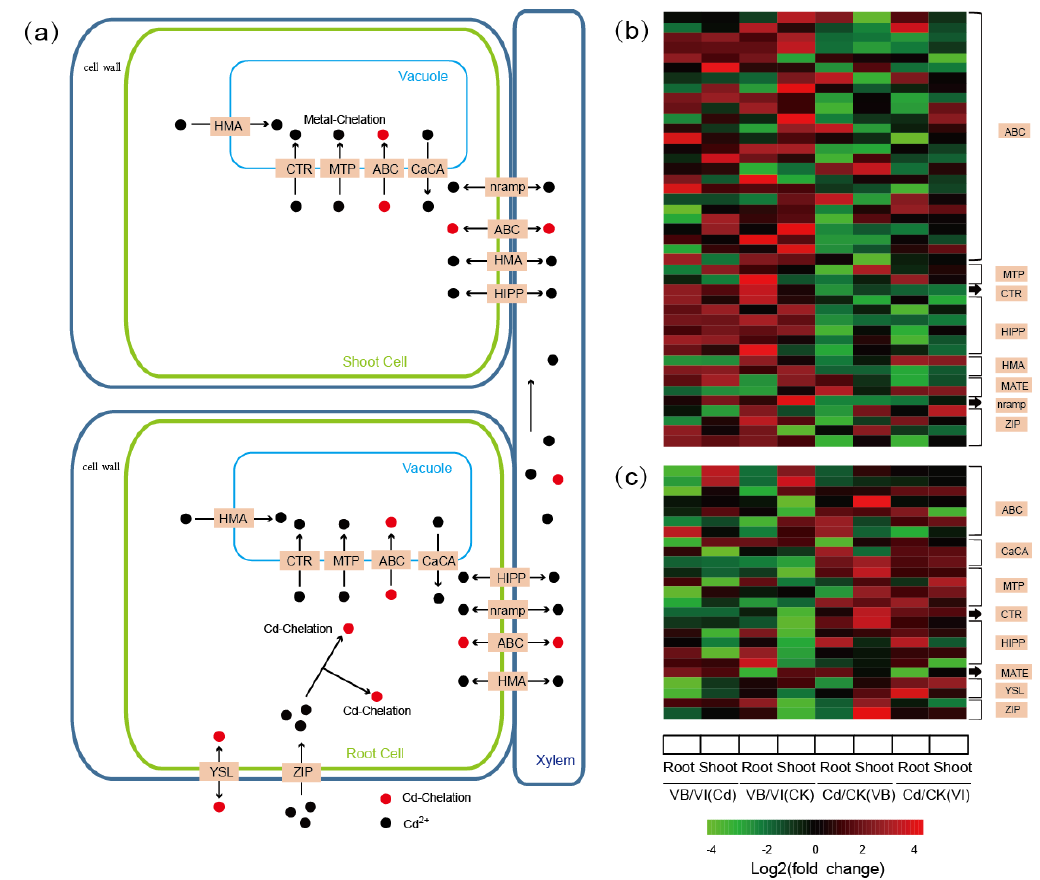
Figure 6. DEGs encoding putative metal transporters. ( a ) A schematic representation of the main processes for differential Cd uptake and internal translocation in Viola species. ( b ) Heat maps of genes encoding putative metal transporters with constitutively higher transcription levels in V. baoshanensis . ( c ) Heat maps of genes encoding putative metal transporters with constitutively higher transcription levels in V. inconspicua . ABC, ATP-binding cassette transporter; CaCA, the Ca 2 + : cation antiporter protein; CTR, the copper transporter protein; HIPP, heavy metal-associated isoprenylated plant protein; HMA, heavy metal ATPase; MATE, multi-antimicrobial extrusion protein; MTP, metal tolerance protein; Nramp, natural resistance-associated macrophage protein; YSL, yellow stripe-like protein; ZIP, the Zinc / Iron permease protein. See more details in Table S13, Sections 2.6 and